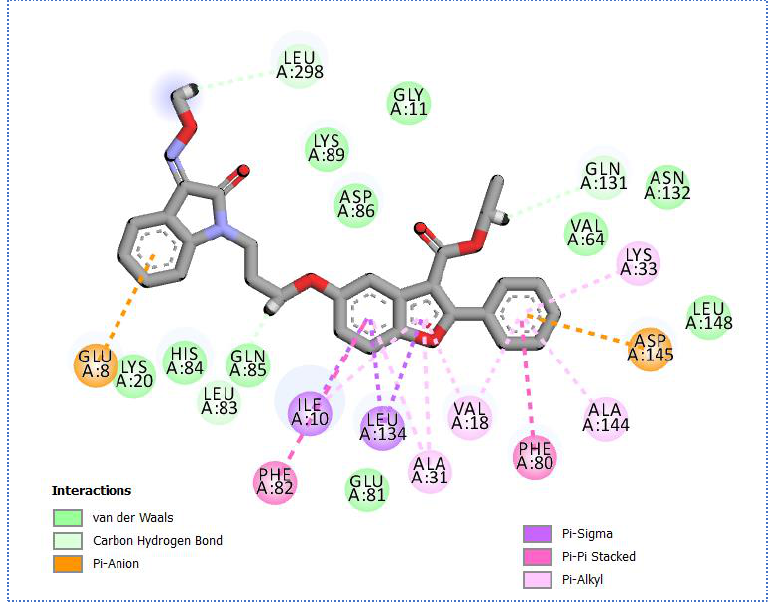
Figure 10. The 2D binding of compound 11 with Cell division protein kinase 2 (PDB ID: 3lfn).